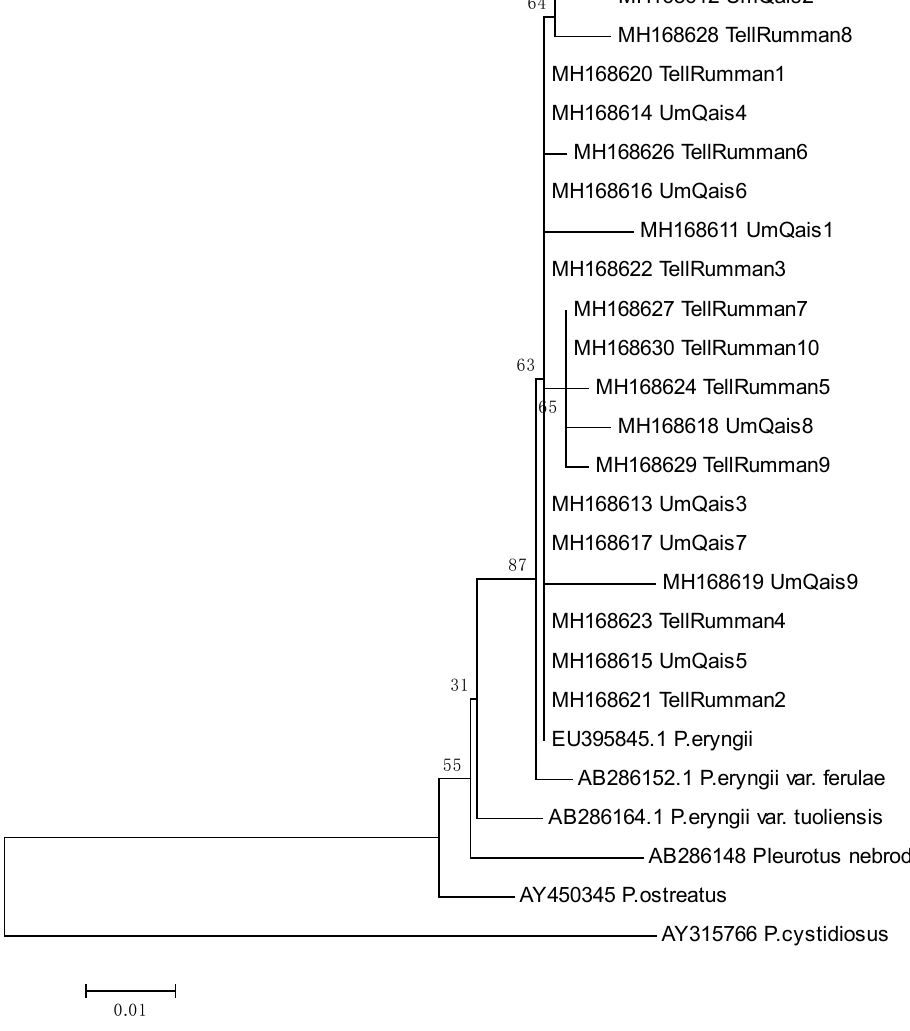
Figure 2. Phylogenetic tree using neighbor-joining analysis between 19 Pleurotus Jordanian isolates collected from two locations (Um-Qais and Tell ar-Rumman) based on ITS sequences and selected reference sequences (GenBank accession number for collected isolates and reference strains are given before the isolate name).